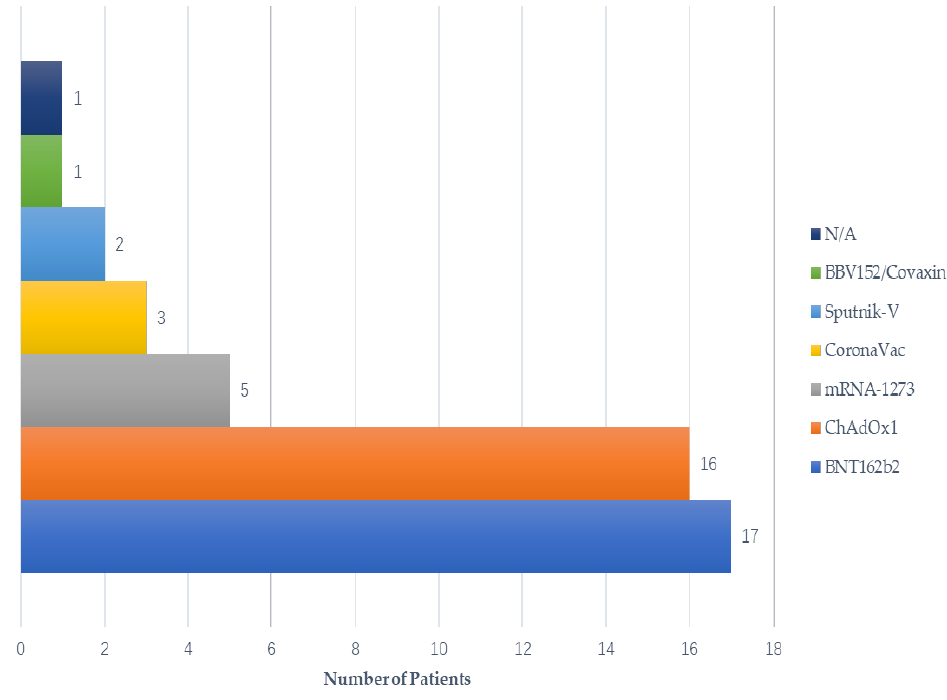
Figure 3. Vaccine type by onset of symptoms.